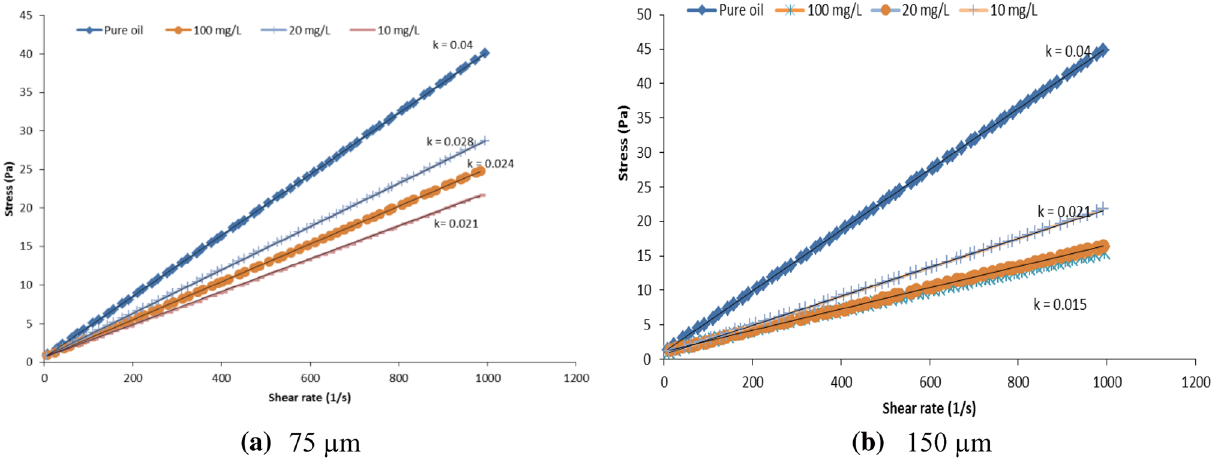
Fig. 8 Consistency index ‘k’ of light crude oil using bio materials